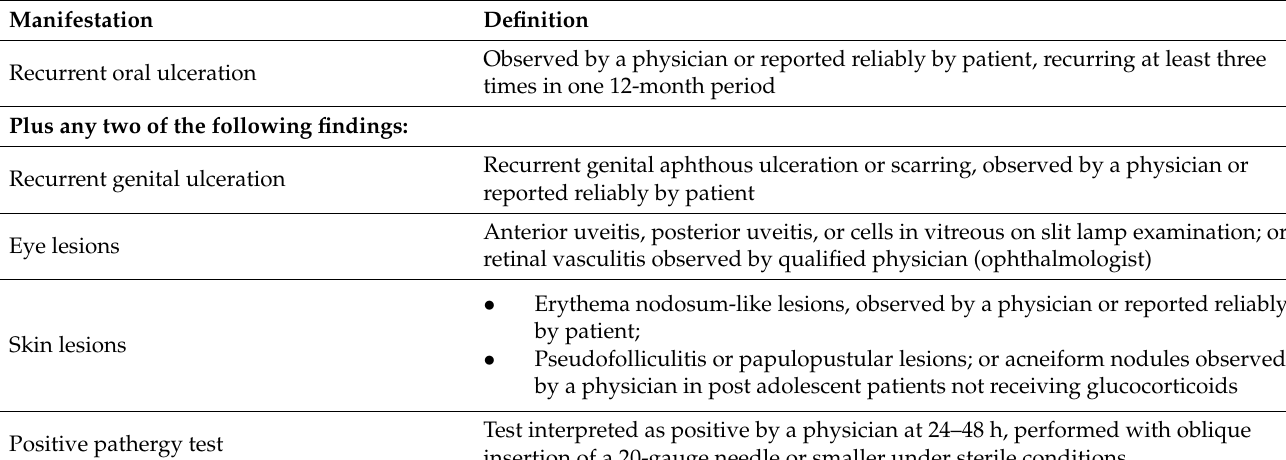
Table 2. International Study Group criteria for the diagnosis of Behçet’s